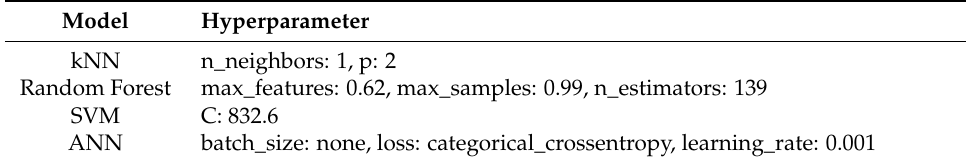
Table 6. Selected parameters and accuracy of each model.